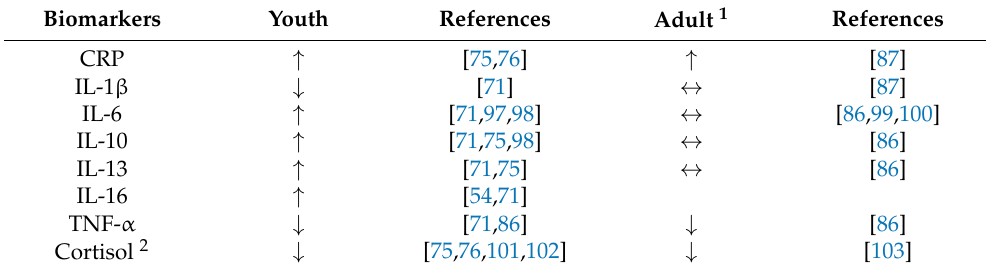
Table 2. Potential inflammatory biomarkers in youth and adult ADHD patients.